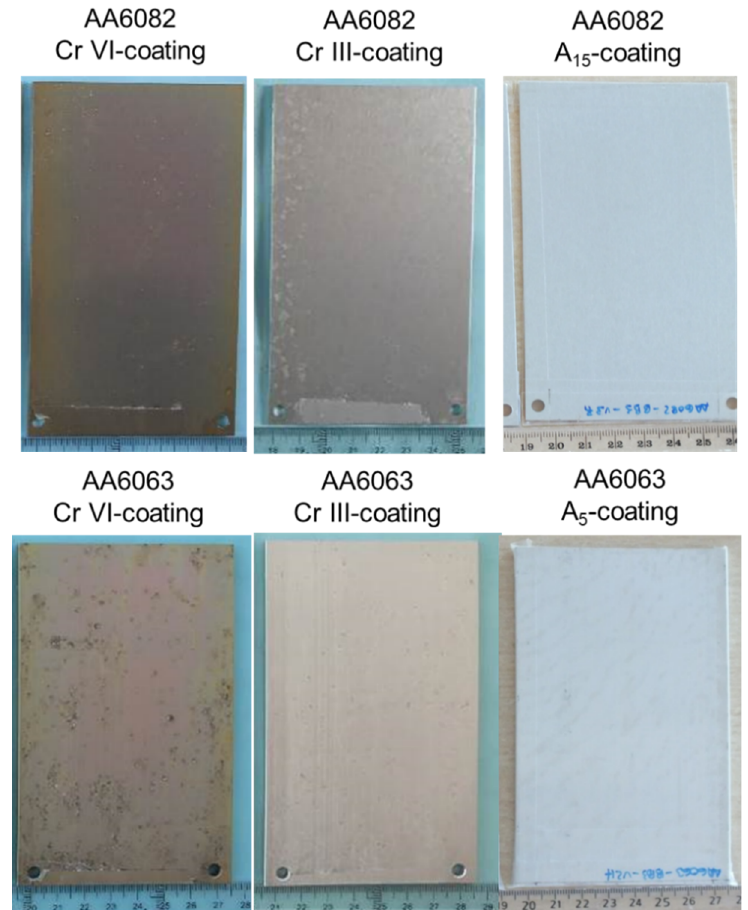
Figure 10. Representative photographs of AA6082 T6 plates coated with Cr VI, Cr III and A coatings after thermal cycling and 24 h of exposure to NSST (above) and same coatings on AA6063 T6 after thermal cycling and 168 h of exposure to NSST (below).